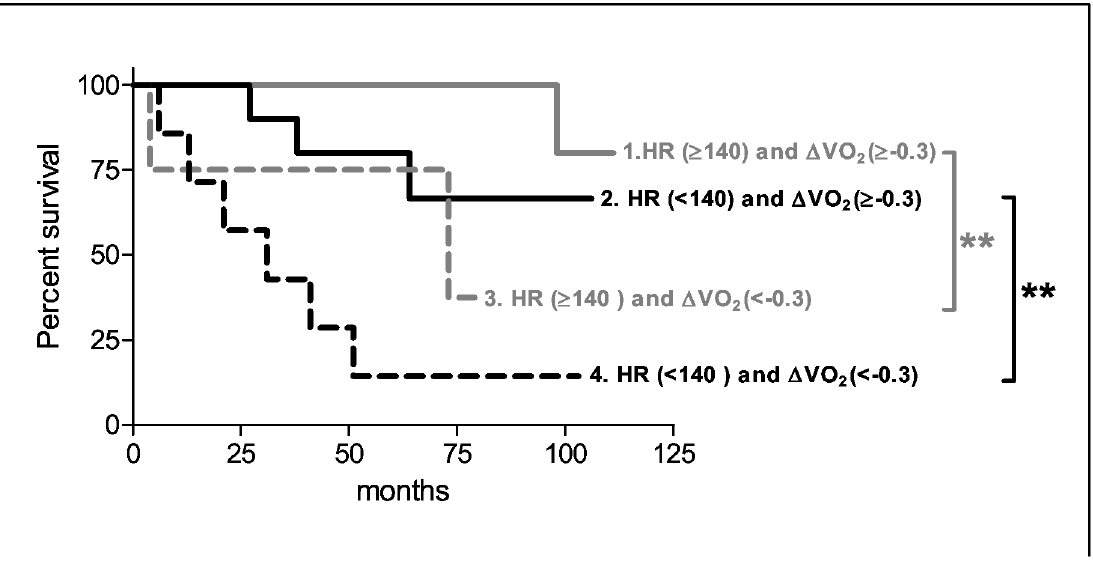
Figure 6. Kaplan- Meier curve of high or low baseline maximal heart rate (HR) in combination with a high or low change of maximal oxygen uptake (ΔVO *kg -1 ) at follow up. ** p < 0.01. 2 doi: